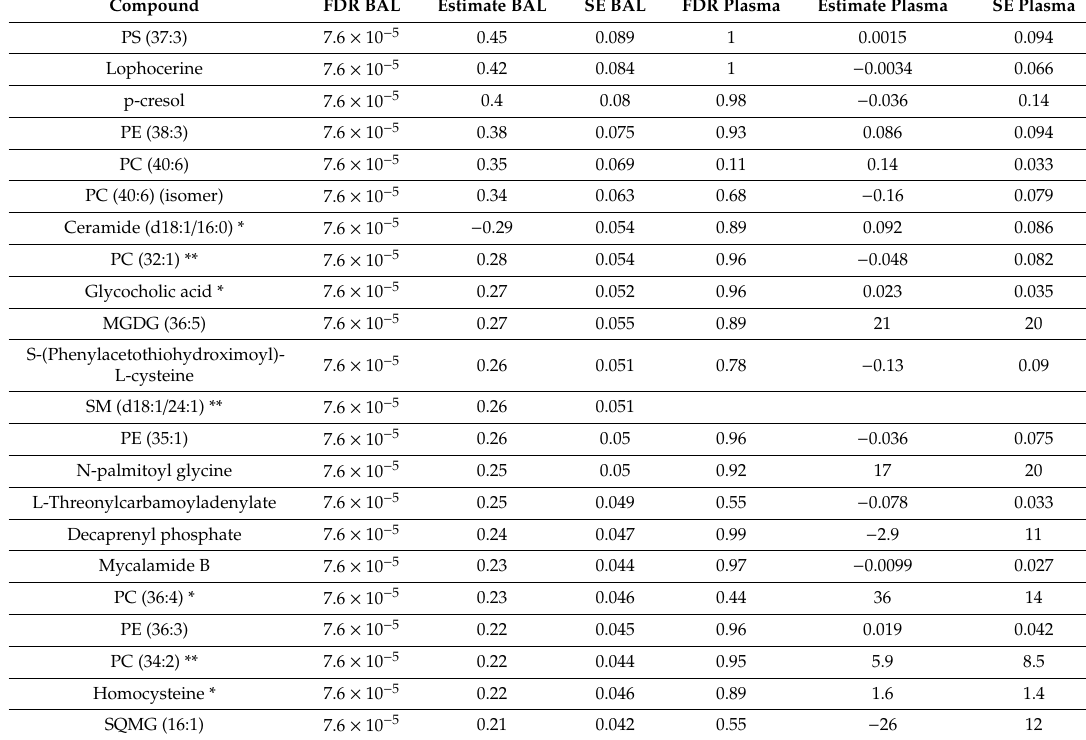
Table3. CompoundsinBALmostsignificantlyassociatedwithFEV 1 / FVCwithcorrespondingplasmaresults. Compound FDR BAL Estimate BAL SE BAL FDR Plasma Estimate